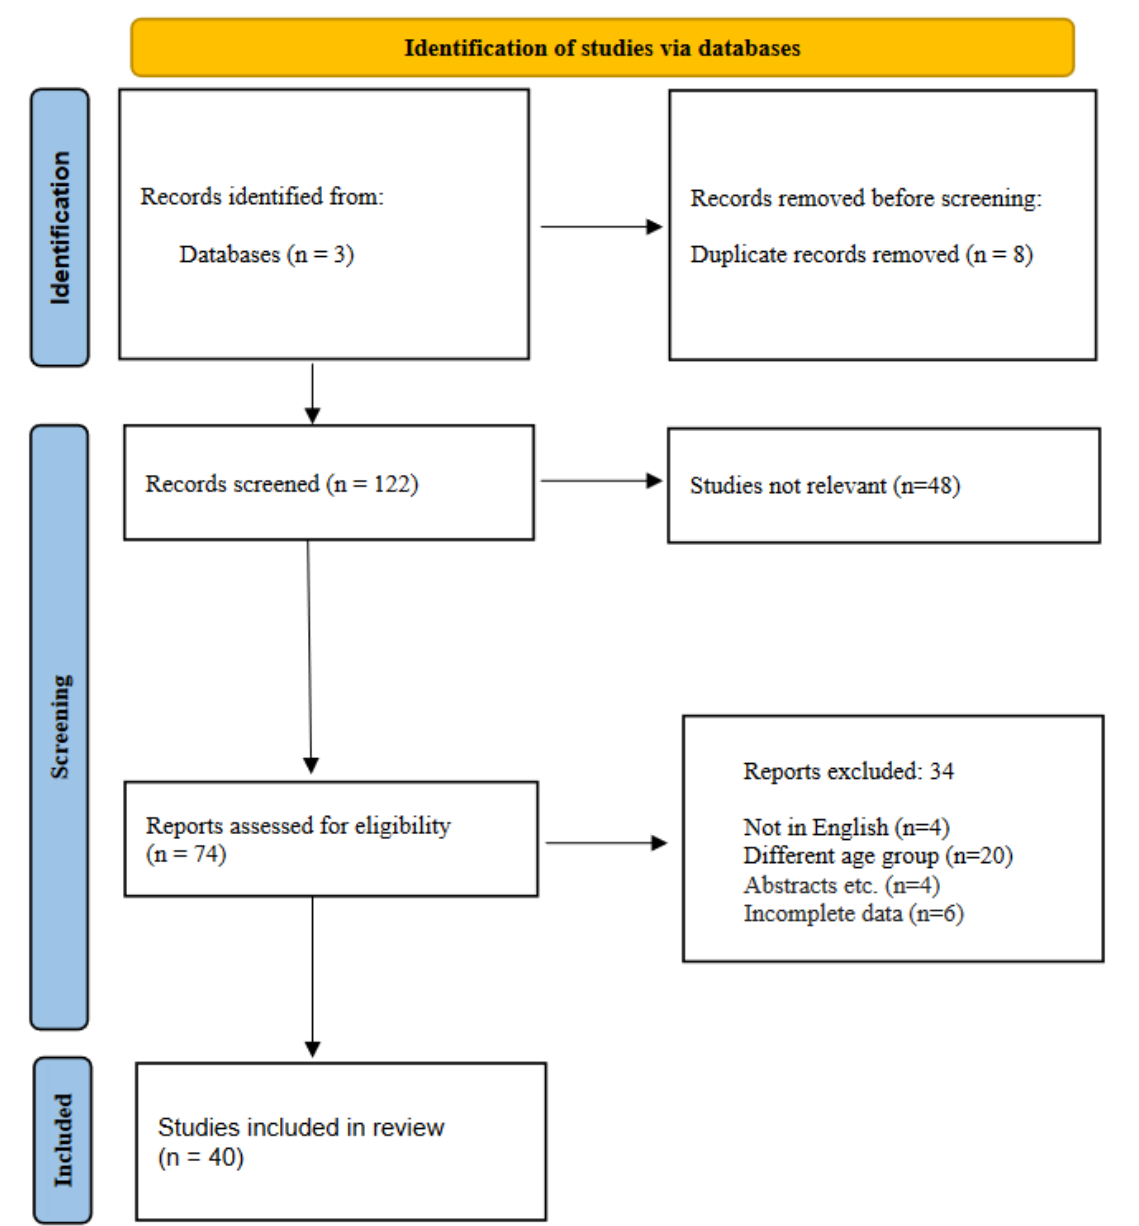
Figure 1. The PRISMA flow diagram of the study selection process.